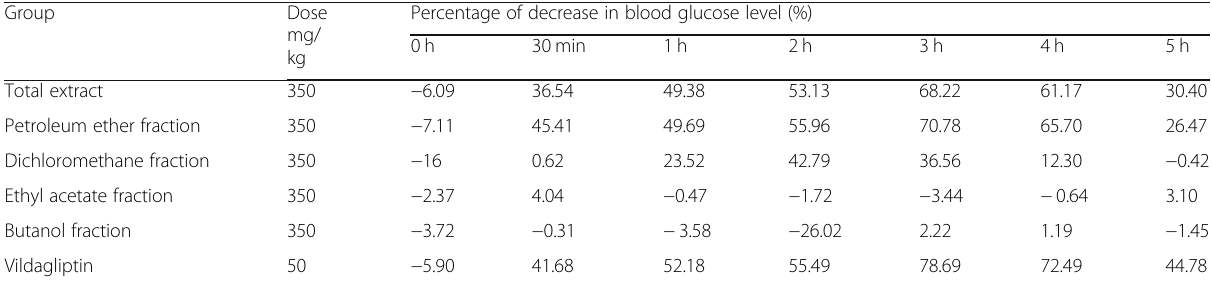
Table 11 Results representing the percentage of decrease in of blood glucose level of the total ethanol extract and the different fractions of C. myxa L. leaves using streptozotocin-induced hyperglycemia method